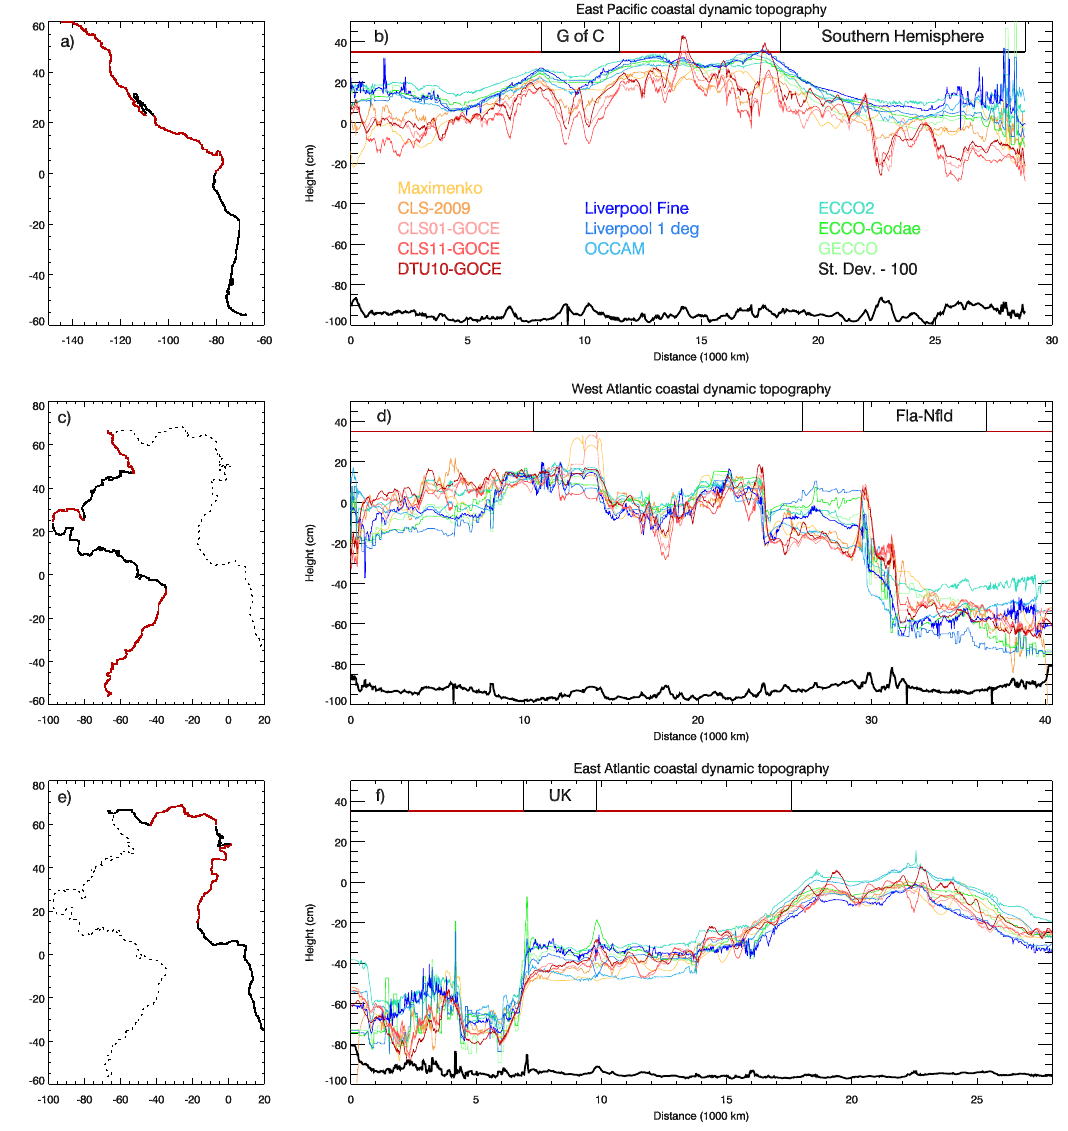
Figure 8. Profiles of MDT for the common 5-year epoch 1996-2000 from the ‘geodetic’ approach (red-orange), from ‘pure’ ocean models in the ‘ocean’ approach (blue) and ocean models which assimilate geodetic information (green-cyan) along (b) the East Pacific, (d) the West Atlantic and (f) the East Atlantic coastlines with model grid values extrapolated to the coast. Stdev values between all MDTs are shown in black at the bottom of each figure, with a -100 cm offset applied. Panels (a), (c) and (e) illustrate the geography of the respective coastlines, with a red/black colour code to help identify particular stretches in the adjacent plots. G of C stands for Gulf of California, and Fla-Nflnd is the coastal stretch from the tip of Florida to Newfoundland.